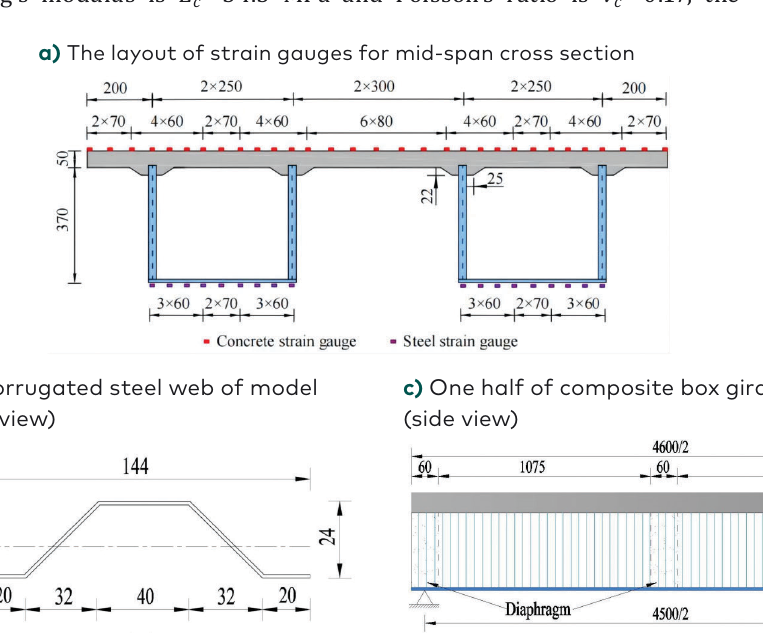
Figure 4. The dimensions and configurations of the CW-SBS model (units in mm)